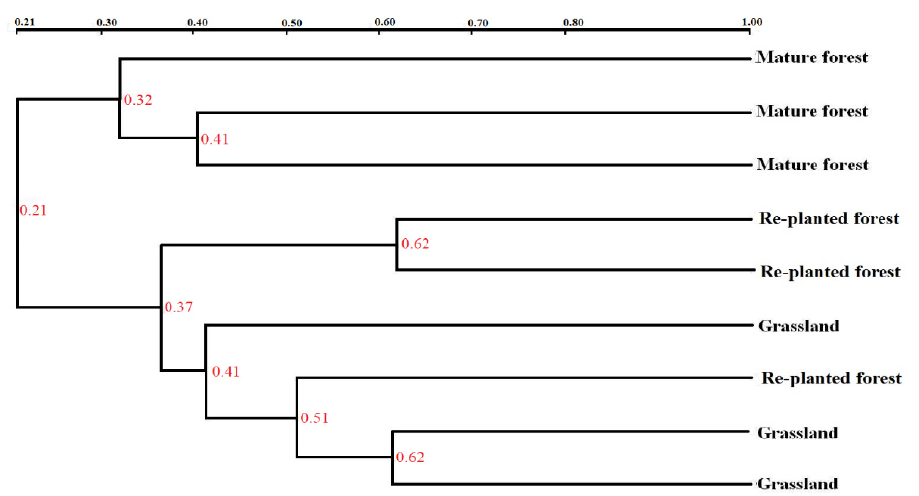
Figure 4. Cluster analysis of fungal community structure in three types of vegetation measured by UPGMA.